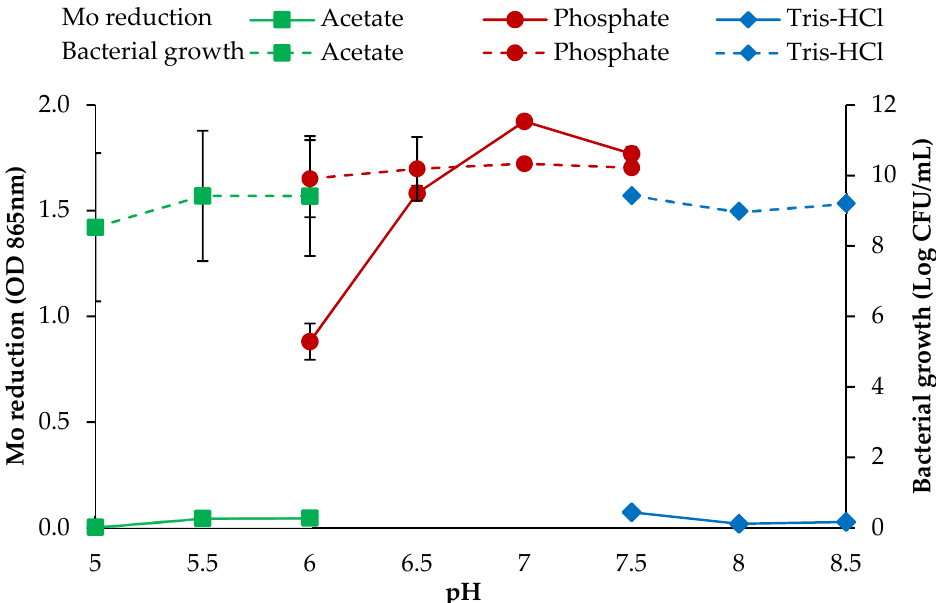
Figure 6. The effects of pH on Mo reduction and growth of strain AQ5-05. The error bars represent the mean ± standard deviation for three replicates.